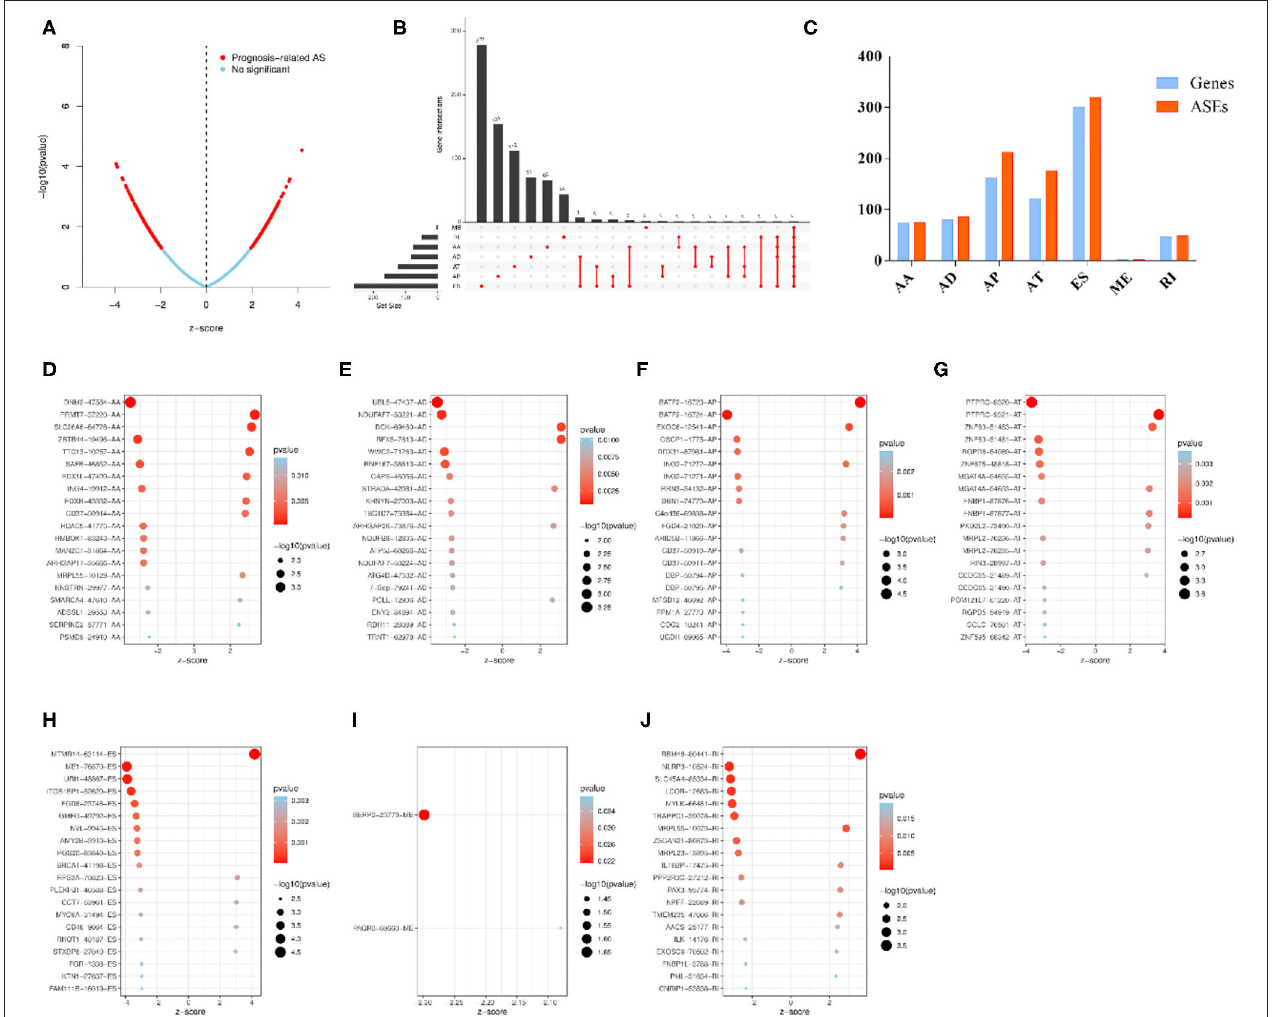
FIGURE 6 | Overview of OS-ASEs affected by mRNA expression-related RBP mutations. (A) The volcano plot of all the ASEs. The red and blue dots represent OS-related and insignificant ASEs, respectively. (B) Upset plot of each type of OS-ASEs in SKCM. The black bar on the left side indicates the number of specific types of ASEs, while the red dots on the right side stand for the splicing intersections. (C) Distribution of seven types of ASEs and their corresponding genes. The x-axis represents each kind of ASEs (AA, AD, AP, AT, ES, RI), and the y-axis represents the number of ASEs (red) as well as the corresponding genes (blue). (D–J) Bubble plot of the most significant OS-ASEs in SKCM. (D) AA; (E) AD; (F) AP; (G) AT; (H) ES; (I) ME; (J) RI. The x-axis represents the z-score of each type of ASEs, while the y-axis stands for the OS-ASEs.